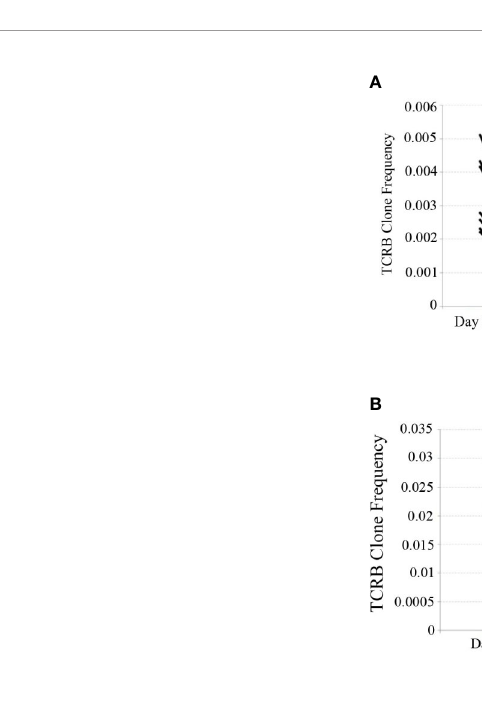
FIGURE 2 | TCRB clonal frequency over time, cord blood transplantation (CBT) patient vs . healthy subject. (A) We have charted the frequency of the 10 most frequent TCRB clones observed 28 days after transplant in one representative CBT patient. These 10 clones were tracked forward in time, and their frequencies at day 56 are plotted. Likewise, we have plotted the change in frequency of the top 10 clones for each pair of adjacent time-points in this patient. Many of the most frequent TCRB clones observed in early time-points either dropped in frequency or disappeared within weeks. By day 180, a drop-in clone frequency between time- points was still evident but most of the top 10 TCRB clones were observed again at some frequency at day 365. (B) We performed a similar analysis for one representative healthy subject. Very little clonal turnover was observed; many of the most frequent TCRB clones persisted across time-points, remaining at similar frequencies throughout the 6-month